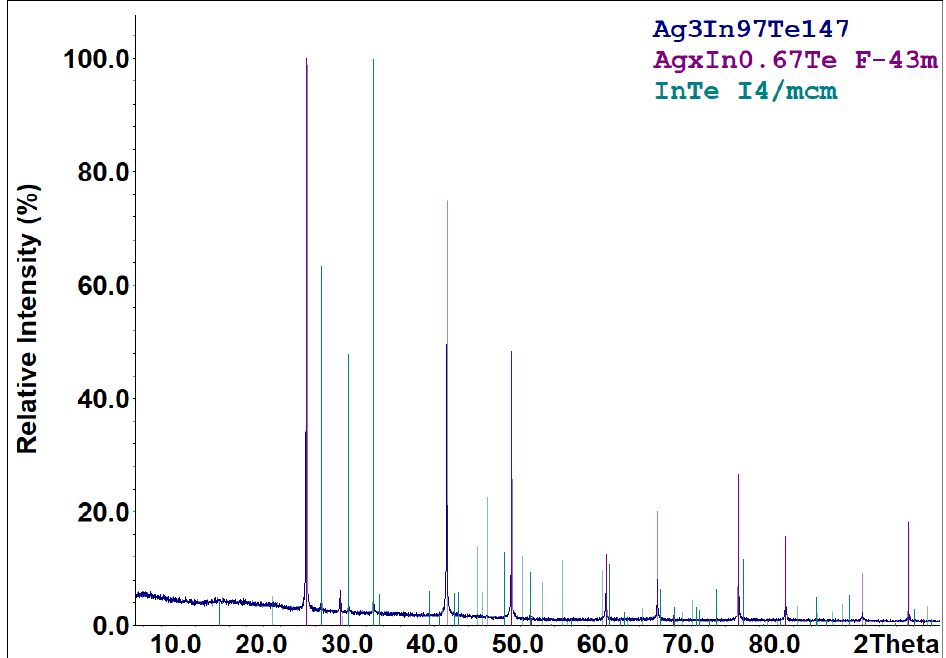
Figure 3. XRPD pattern of the sample with the nominal composition Ag 3 In 97 Te 147 . Compositions of the sample and identified phases (with space group indicated) are shown in the upper-right corner.